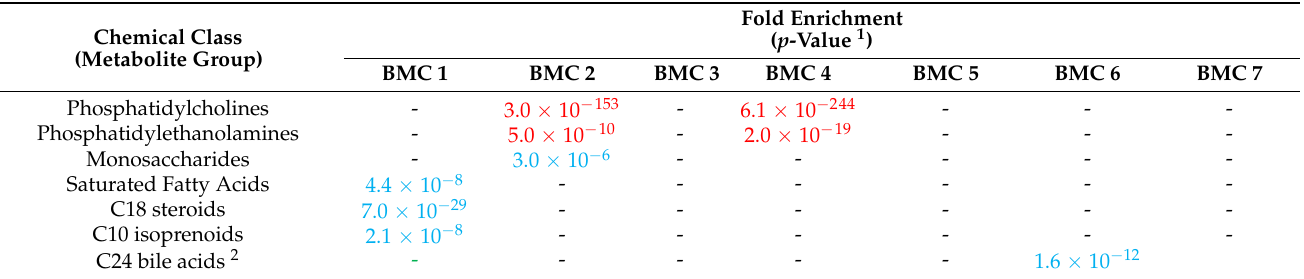
Table 1. Composition of the blood metabolome components (BMCs) determined by their enrichment with chemical classes.